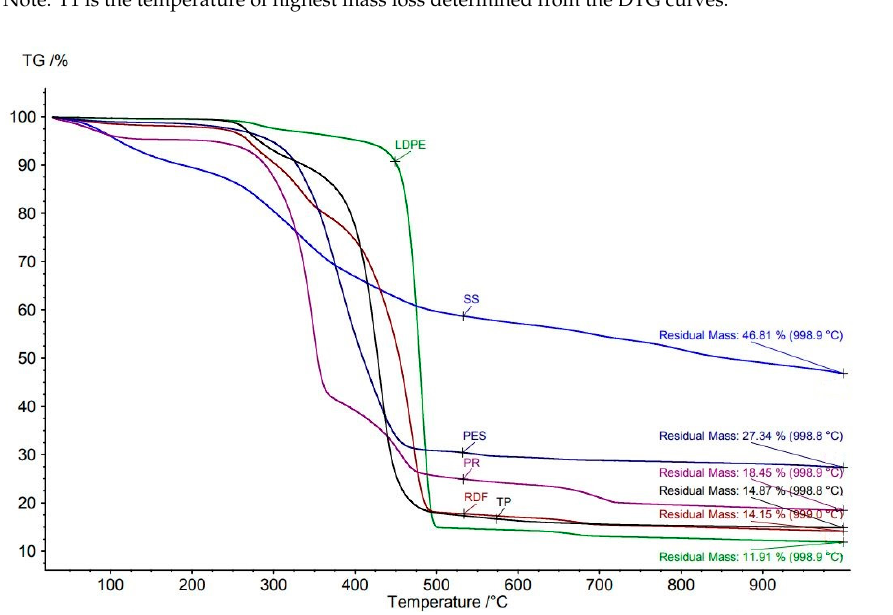
Figure 8. TG curves of input waste